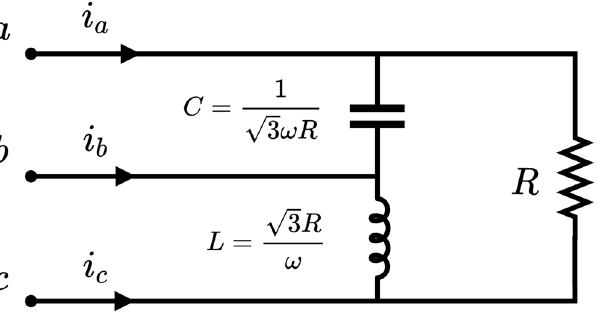
Figure 5. Steinmetz compensator. An inductor and a capacitor are added to the resistor in Fig. 3 to restore the symmetry in the currents.